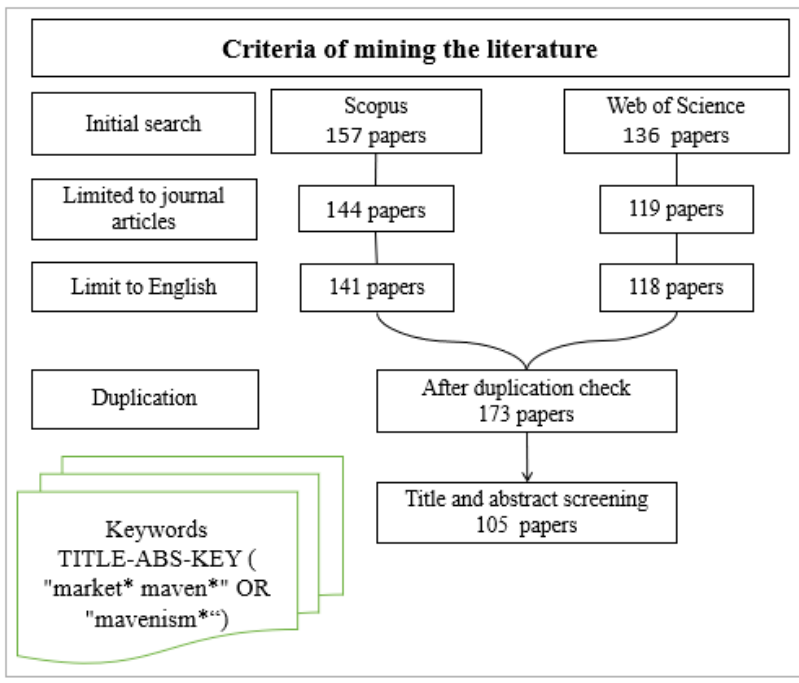
Figure 1. The process of collecting the sample